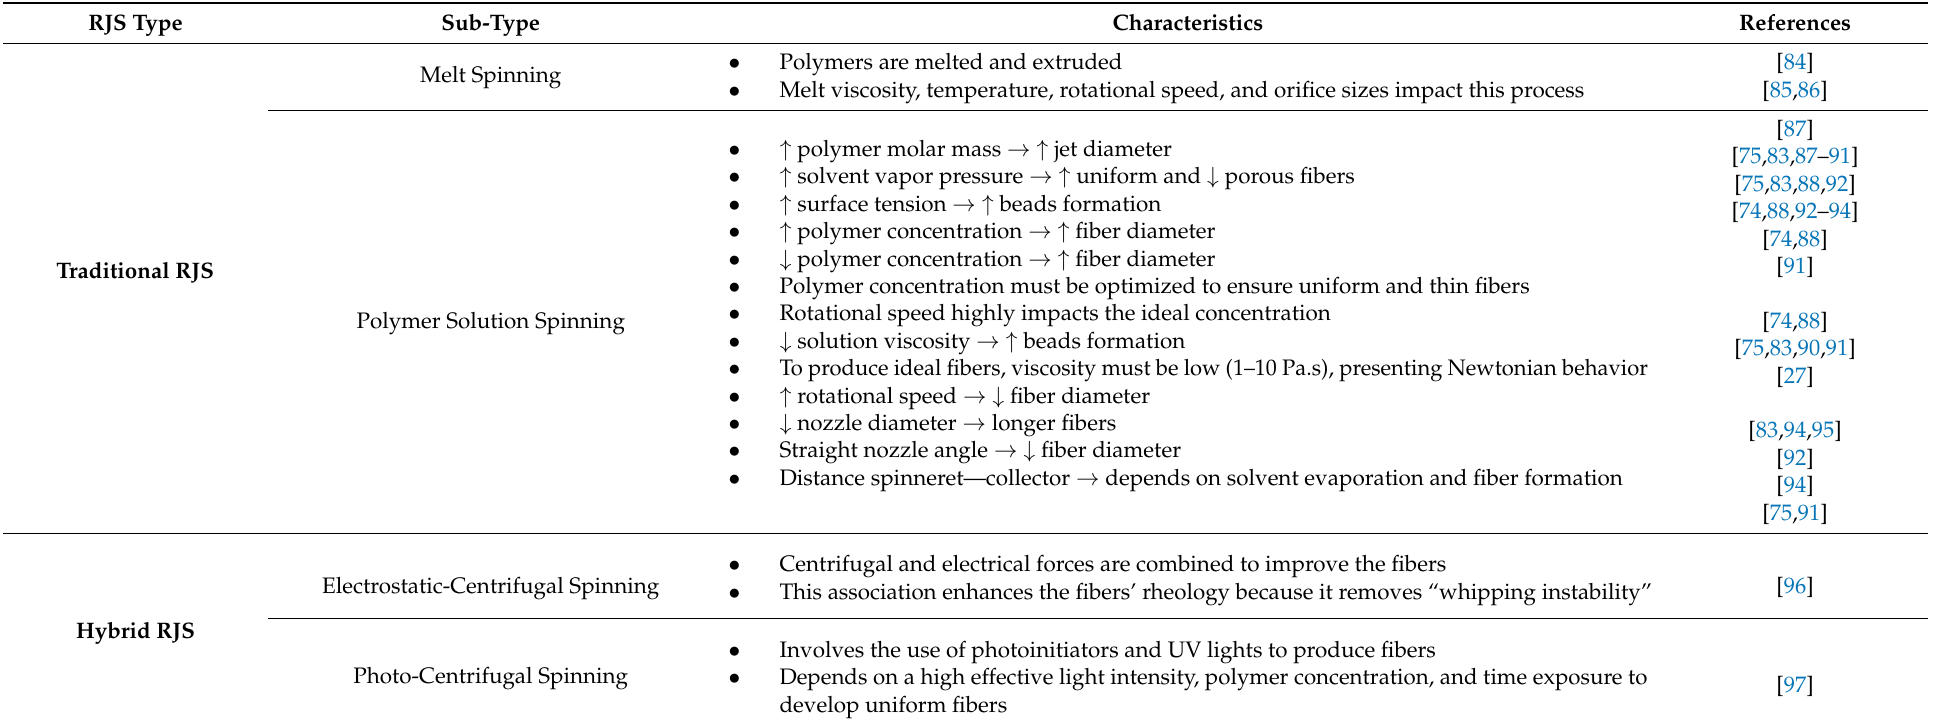
Table 2. Parameters that affect the properties of the RJS resulting